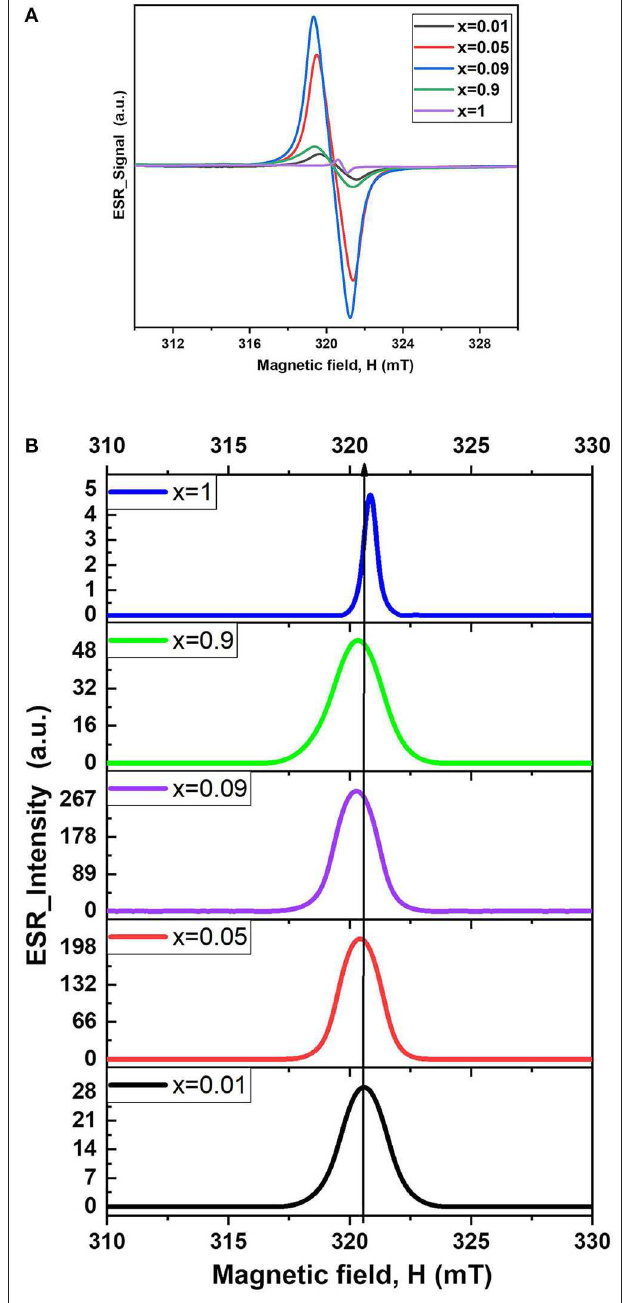
in Figure 5 demonstrate week shift of the resonance towards lower field values by the doping of indium from x = 0.01 to x = 0.9, resulting in the shift of the g -factor from 2.0045 to 2.0065. In the range of x = 0.01 to x = 0.09, the integral intensity of the ESR spectra grows up with increase of the